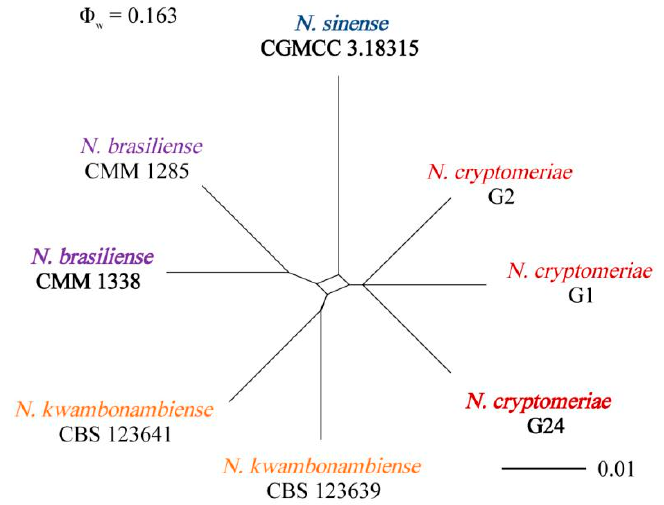
Figure 4. Pairwise homoplasy index (PHI) test of Neofusicoccum cryptomeriae and closely related N. sinense , N. brasiliense , and N. kwambonambiense using both LogDet transformation and splits decomposition. PHI test results ( Φ w ) < 0.05 indicate significant recombination within the dataset.